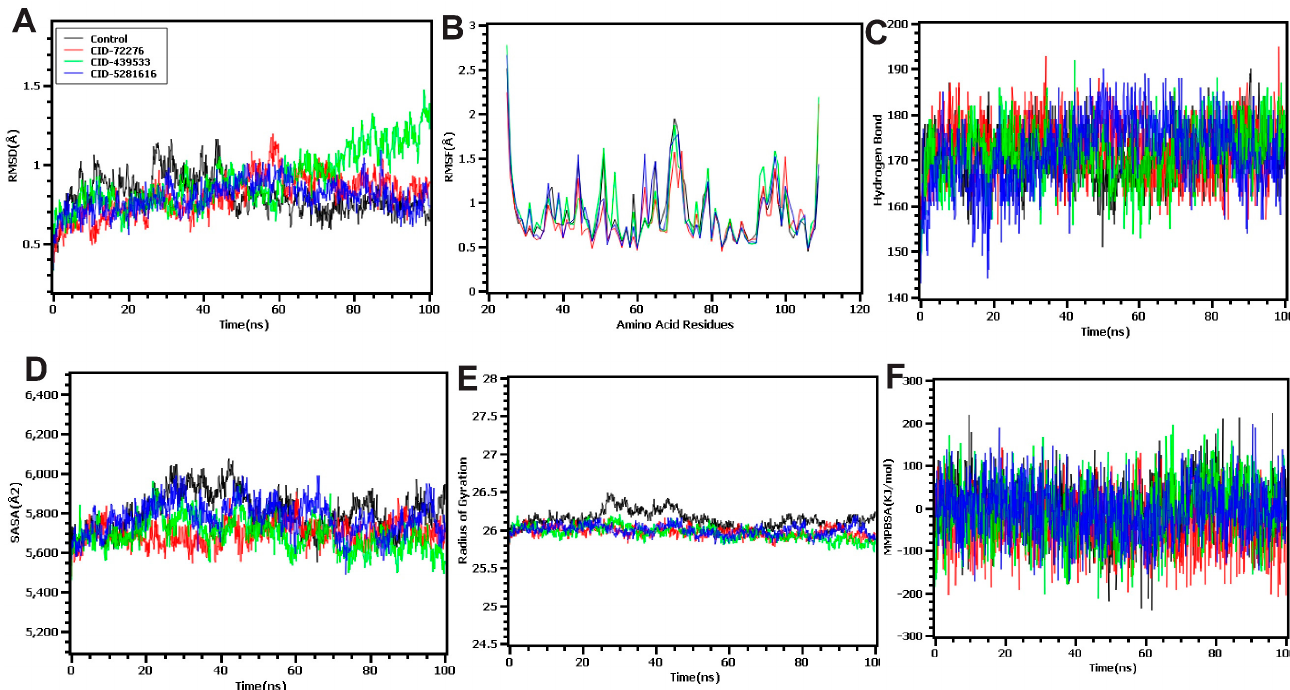
Figure 11. ( A ) The graph showed the RMSD data of all protein–ligand complexes at 100 ns duration of the simulation. ( B ) Diagrammatic illustration of RMSF values of five complexes. ( C ) The graph shows the number of hydrogen bond interactions. ( D ) The diagram showed the SASA values of all complex structures (protein-ligand) at 100 ns. ( E ) The graph shows the Rg values of protein–ligand complexes. ( F ) The chart depicted the importance of MMPBSA of all the protein–ligand complexes at a 100 ns simulation period. All MDS evaluations of the control drug were displayed by ash colour, whereas the compounds CID-439533, CID-72276, and CID-5281616 were shown in green, orange, and blue,